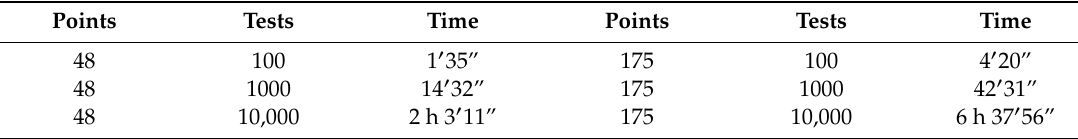
Table 2. Computational time for di ff erent test